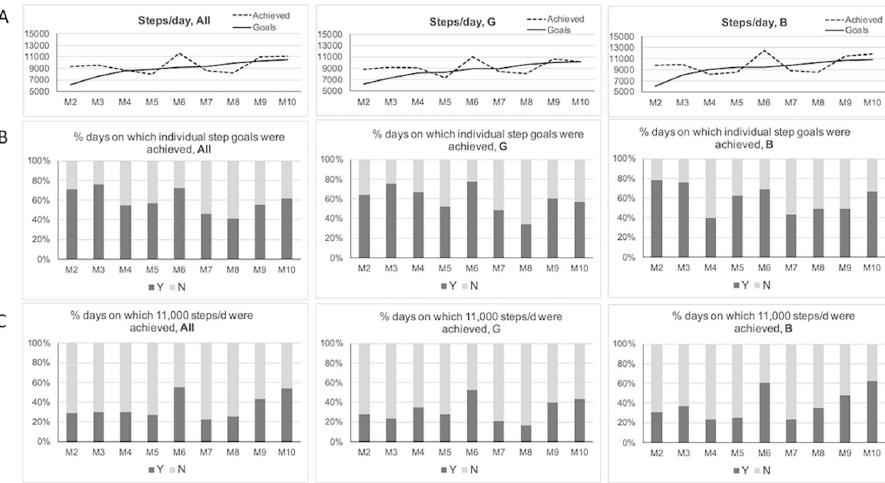
Fig 4. Self-reported achievements. Daily steps reported by the adolescents in each module. The step value reported for each module is the average of daily steps performed during the 2 or 3 previous days (between 2 modules). Panel A: averaged daily steps goals and achievements reported by adolescents in the app as part of each module’s self- monitoring activities. Panel B: proportion of days on which individual step goals were achieved (based on self-report of step data). Panel C: % of days on which 11,000 steps/d were achieved calculated from self-reported step data. �� : P < 0.01, Chi Square test. Compared to predicted form M2 (30% Yes and 70% No). All: all participants (n = 57), B: boys (n = 28), G: girls (n =